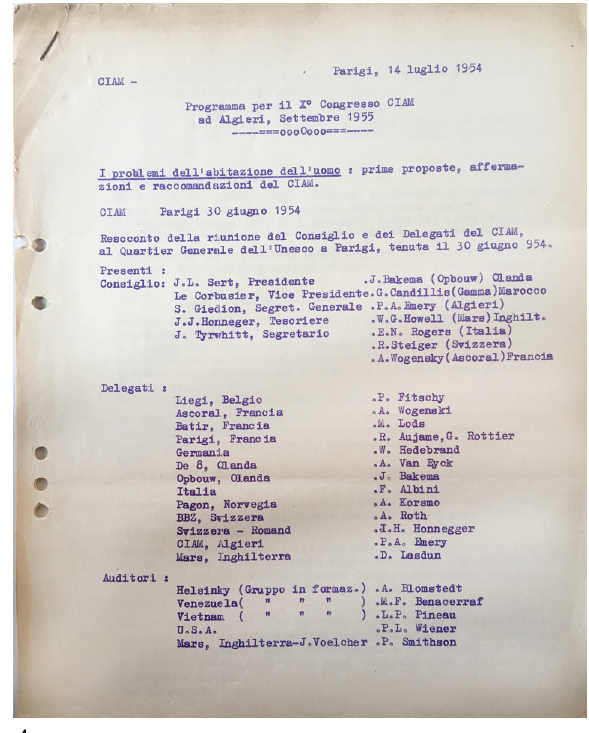
Fig. 4 “Programma per il X Congresso CIAM ad Algeri, Settembre 1955”. From: Università Iuav di Venezia-Archivio Progetti, fondo Giancarlo De